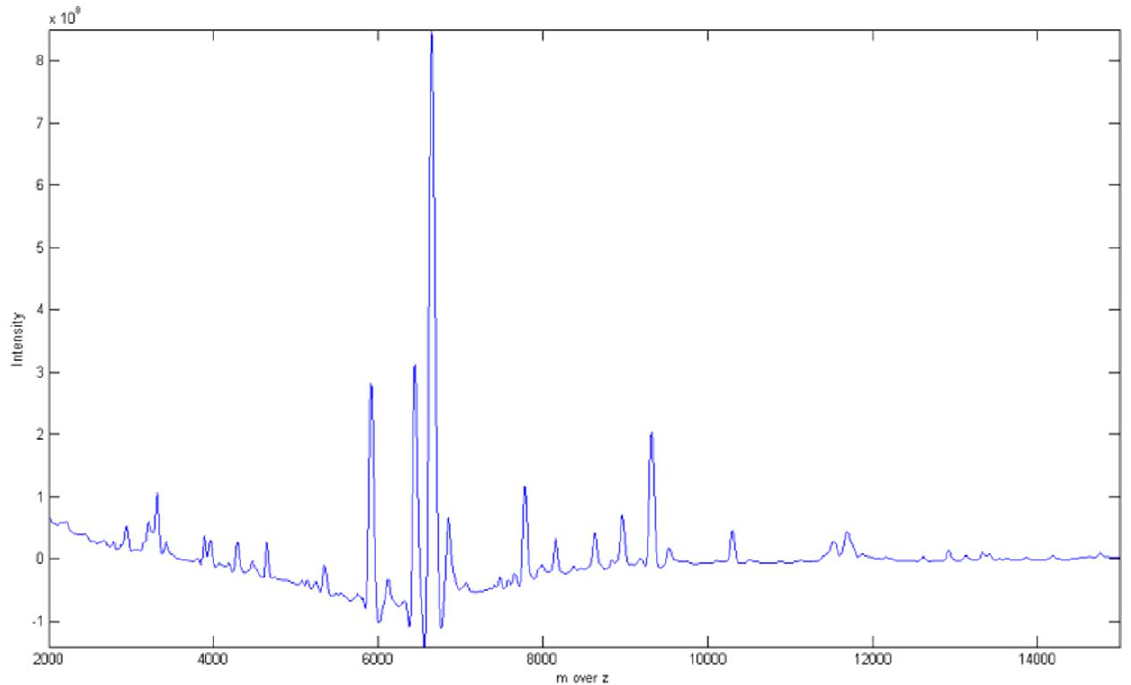
Figure 4. Different peaks detected by different peak selection method. (a) The ovarian cancer dataset preprocessed by HHTMass1. The chosen area is from 4000DA to 6000DA. The figure is the original spectrum and the circled points are the peaks detected by HHTMass1. HHTMass1 detected 32 peaks in this region. (b) The ovarian cancer dataset preprocessed by HHTMass2. The chosen area is from 4000DA to 6000DA. The figure is the original spectrum and the circled points are the peaks detected by HHTMass2. HHTMass1 detected 17 peaks in this region. (c) The ovarian cancer dataset preprocessed by HHTMass3. The chosen area is from 4000DA to 6000DA. The figure is the original spectrum and the circled points are the peaks detected by HHTMass3. The largest peak in the region between 5000DA and 6000DA was not detected by HHTMass3. HHTMass3 detected 18 peaks in this region.